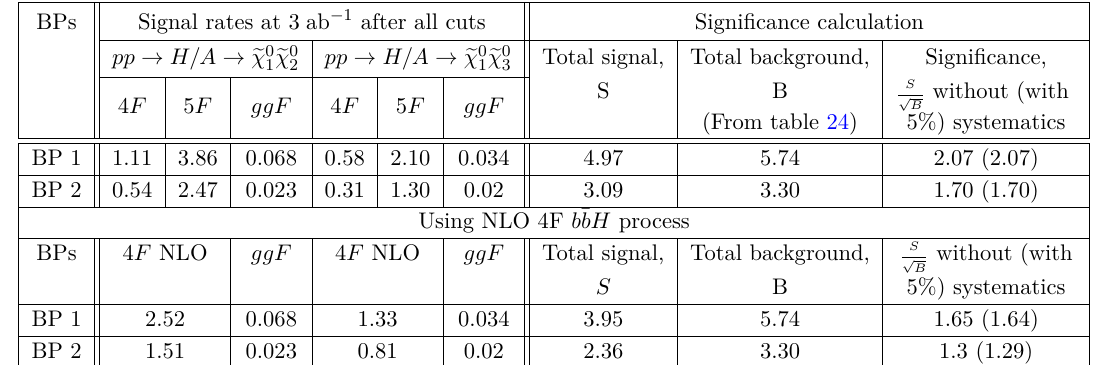
Table 25. The signal yield along with signal significance for the b-tag γγ + /E The ‘‘ + /E channel can give rise to promising signature at the collider with higher T